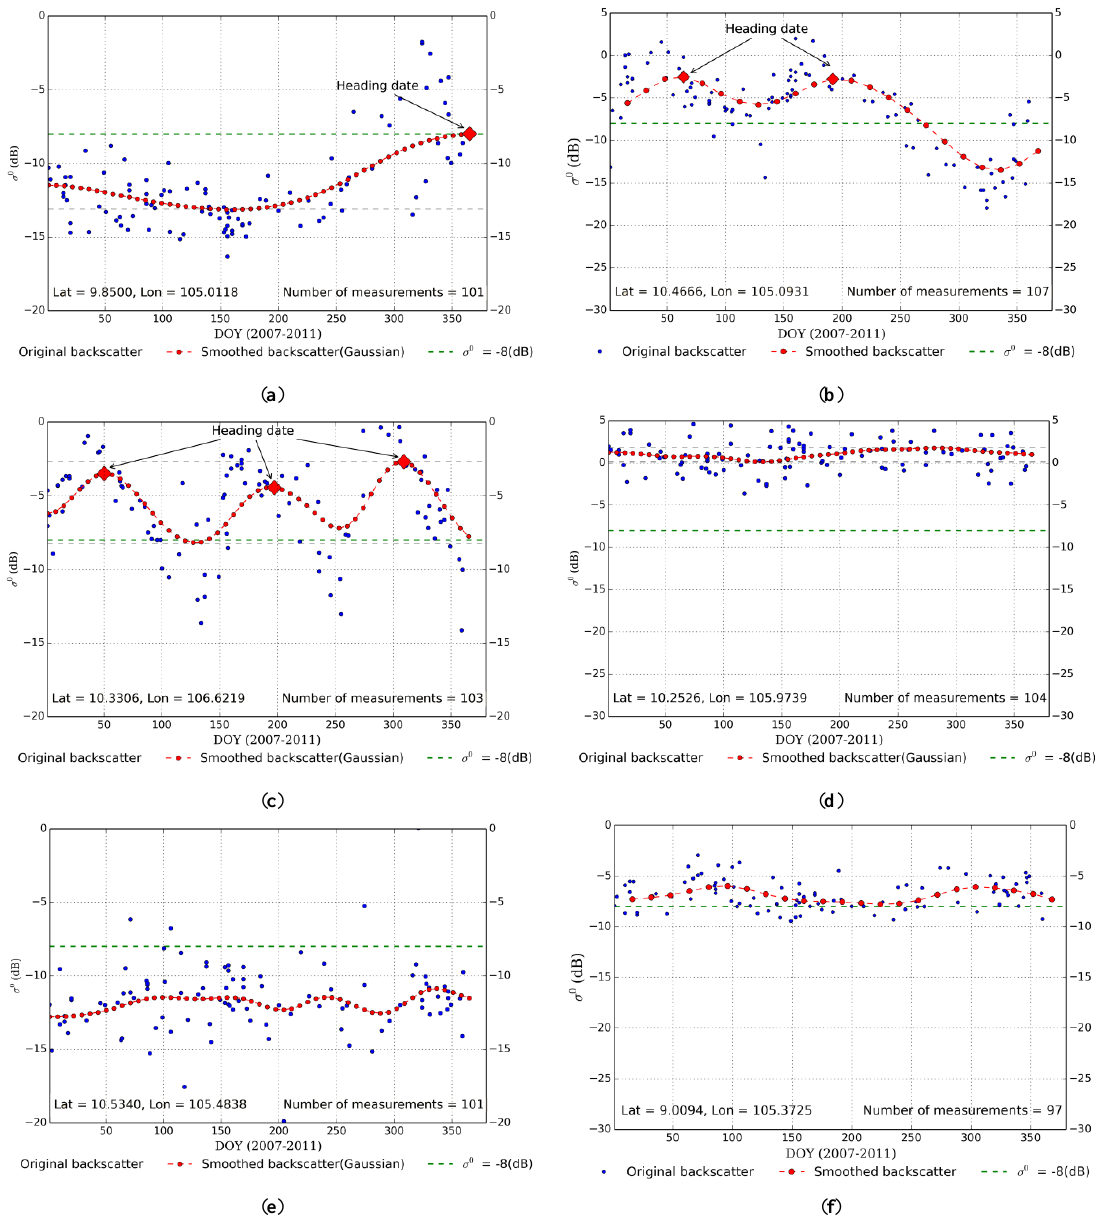
Figure 9. Normalized backscatter time series σ o compared to the averaged, smoothed time serie σ o for six different land-cover types. ( a ) Single-cropped rice. ( b ) Double-cropped rice. ( c ) Triple-cropped rice. ( d ) Urban. ( e ) Water. ( f ) Mangrove